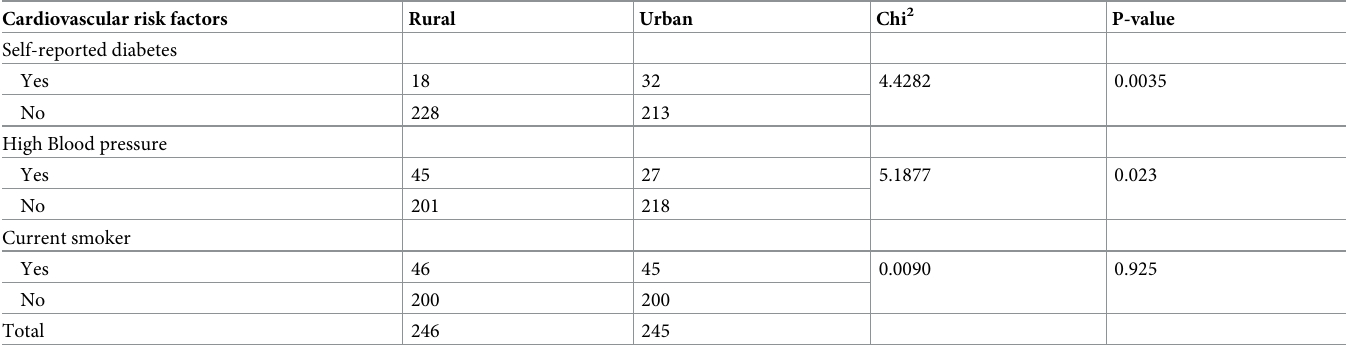
Table 4. Distribution of three major CVD risk